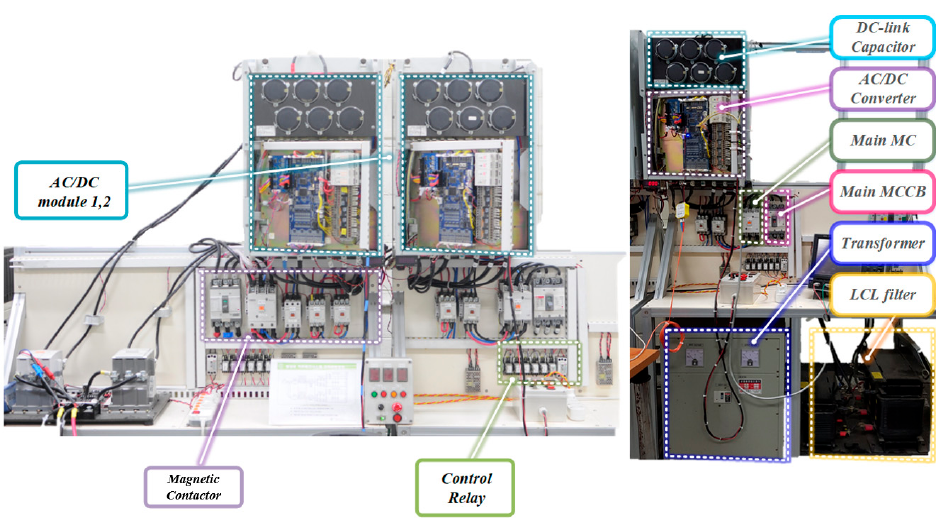
Figure 8. Experiment configuration of interfacing converter.